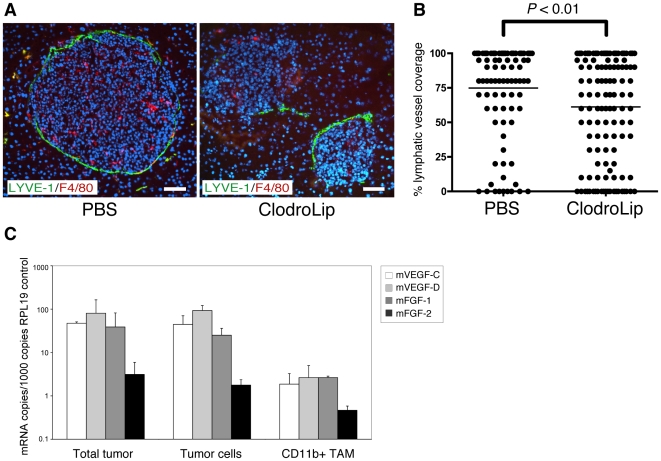
Depletion of macrophages reduces peritumoral lymphatic vessel density.(A) RT2;VC mice were treated with liposome-encapsulated Clodronate (ClodroLip). Pancreatic sections representing a total of 5 PBS vehicle control-treated mice (97 tumors) and 6 ClodroLip-treated (132 tumors) mice were analyzed. Successful depletion of intra- and extra-tumoral macrophages in ClodroLip-treated mice is illustrated by the reduction of F4/80 immunoreactivity (red). Co-staining with the lymphatic endothelial marker LYVE-1 (green) reveals a reduced coverage of tumors by lymphatic vessels in ClodroLip-treated mice vs. in PBS-treated mice. DAPI was used for nuclear counterstaining (blue). T: tumor. Scale bar: 50 µm. (B) Tumors of ClodroLip and control-treated mice were analyzed by immunofluorescence staining with antibodies against LYVE-1 for the extent of lymphatic vasculature surrounding the perimeter of the tumors. Tumors of control-treated mice were surrounded by 90% or more with lymphatic vessels (median 90%, mean 74.9%), whereas tumors of ClodroLip-treated mice had significantly lower coverage (median 70%, mean 61.1%; P<0.01, Mann-Whitney test). (C) Tumor-associated CD11b+ macrophages (TAM) and tumor cells were isolated from tumors of RT2;VC mice by flow cytometry, and mRNA levels for murine VEGF-C, VEGF-D, FGF-1 and FGF-2 were determined using quantitative RT-PCR and compared to levels in total tumors. Shown is the result of three independent cell isolations. ΔCT values have been calculated and normalized to internal control (RPL19) CT value. The results are displayed as mRNA copies per 1000 copies of control RPL19 mRNA to visualize the relative levels of mRNA of interest to internal RPL19 control mRNA.